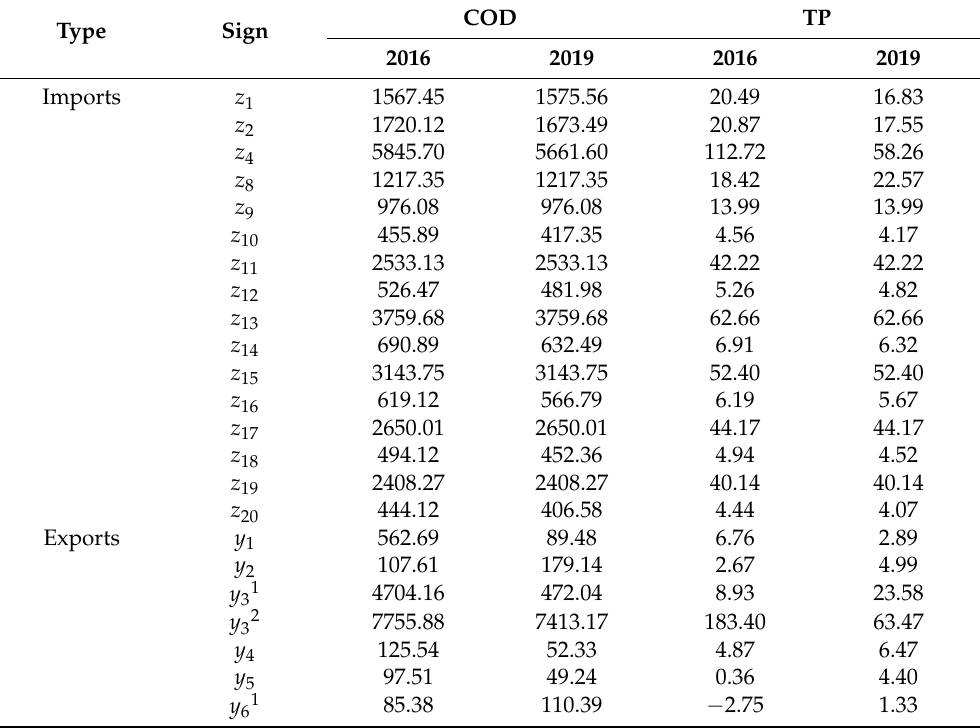
Table 6. Ecological network flows of the old part of Fuzhou city in years of 2016 and 2019 ( × 10 3